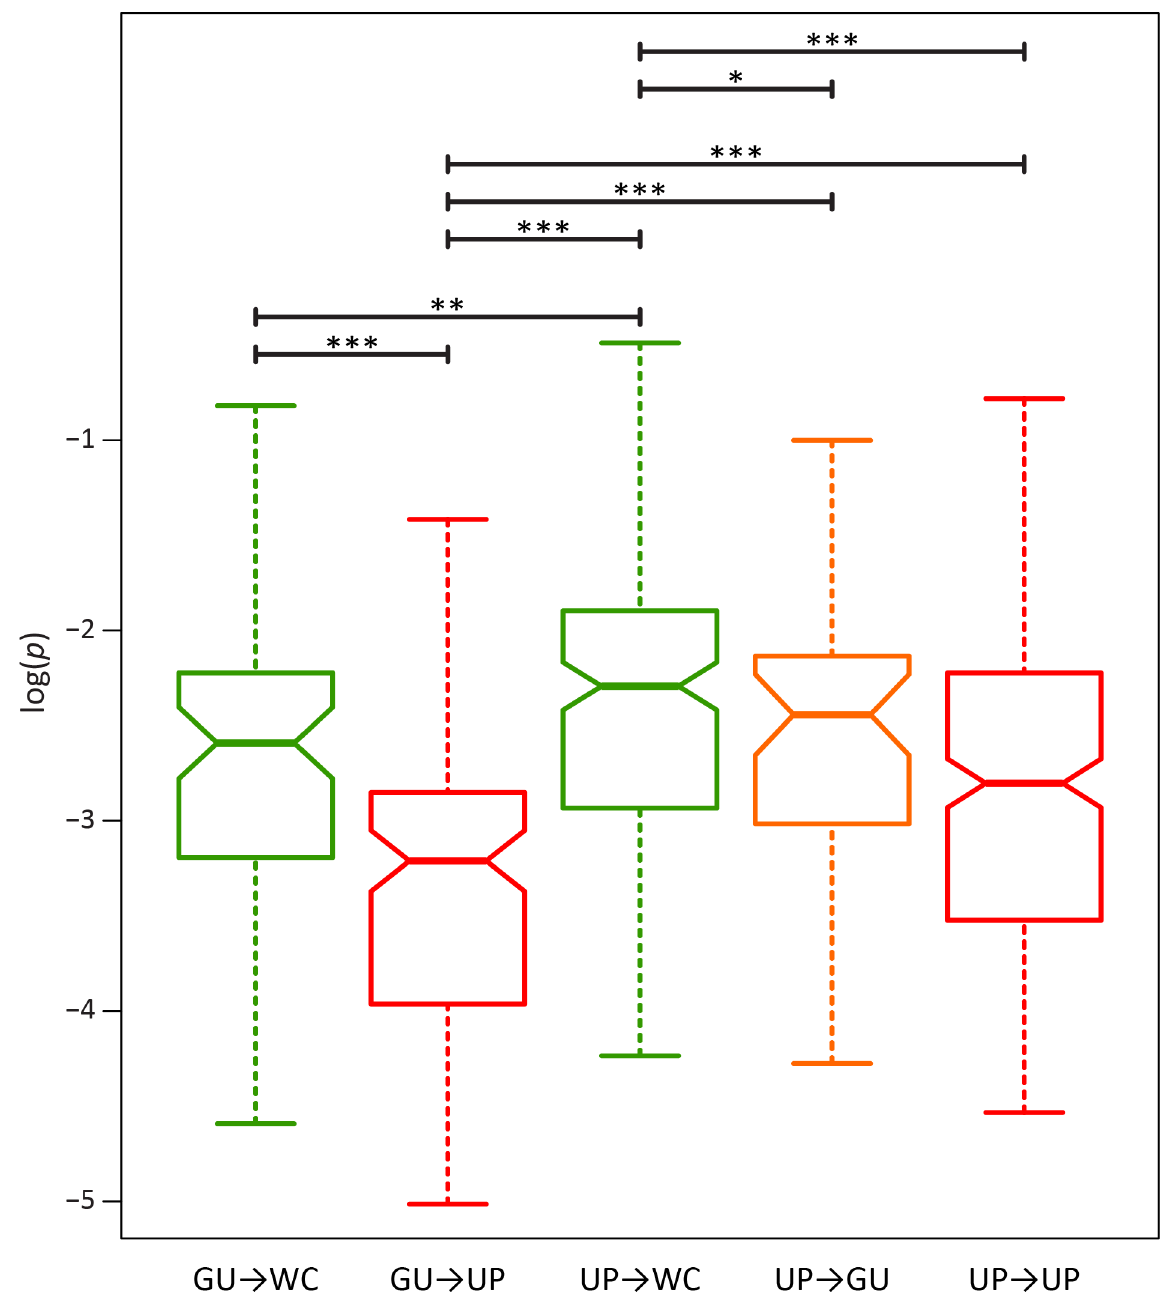
Figure 4. Intra-population frequencies of second-site WC replacement polymorphisms in the HIV-1 genome. Frequencies are normalized to enable comparisons among classes (see Materials and Methods for details) and plotted on a log 10 -scale. Asterisks indicate p , 0.05 (*), p , 0.01 (**), and p , 0.001 (***).